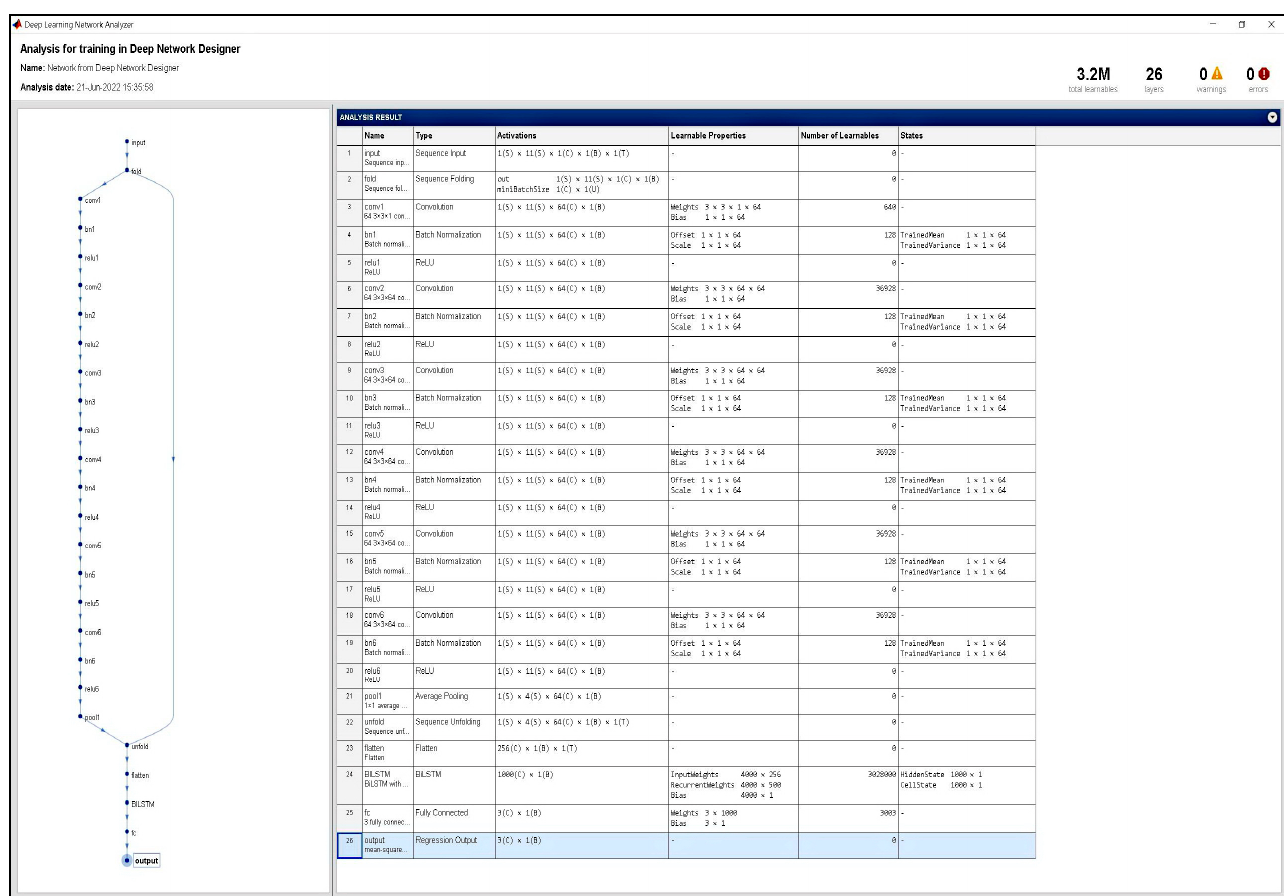
Figure 3. The analysis and validation of the obtained DAGNN architecture design.